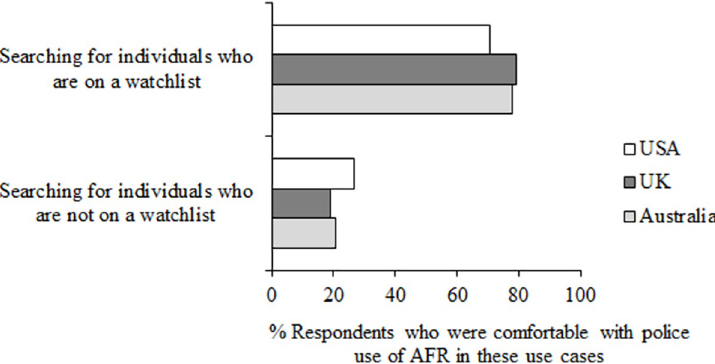
Fig 7. Questions 8–9 data. Percent of participants who were comfortable (responding 4, 5 or 6 on the scale of comfort) to questions 8 and 9 “How comfortable do you feel with police in your country using facial recognition technology to search for individuals who are/are not on a watchlist”.